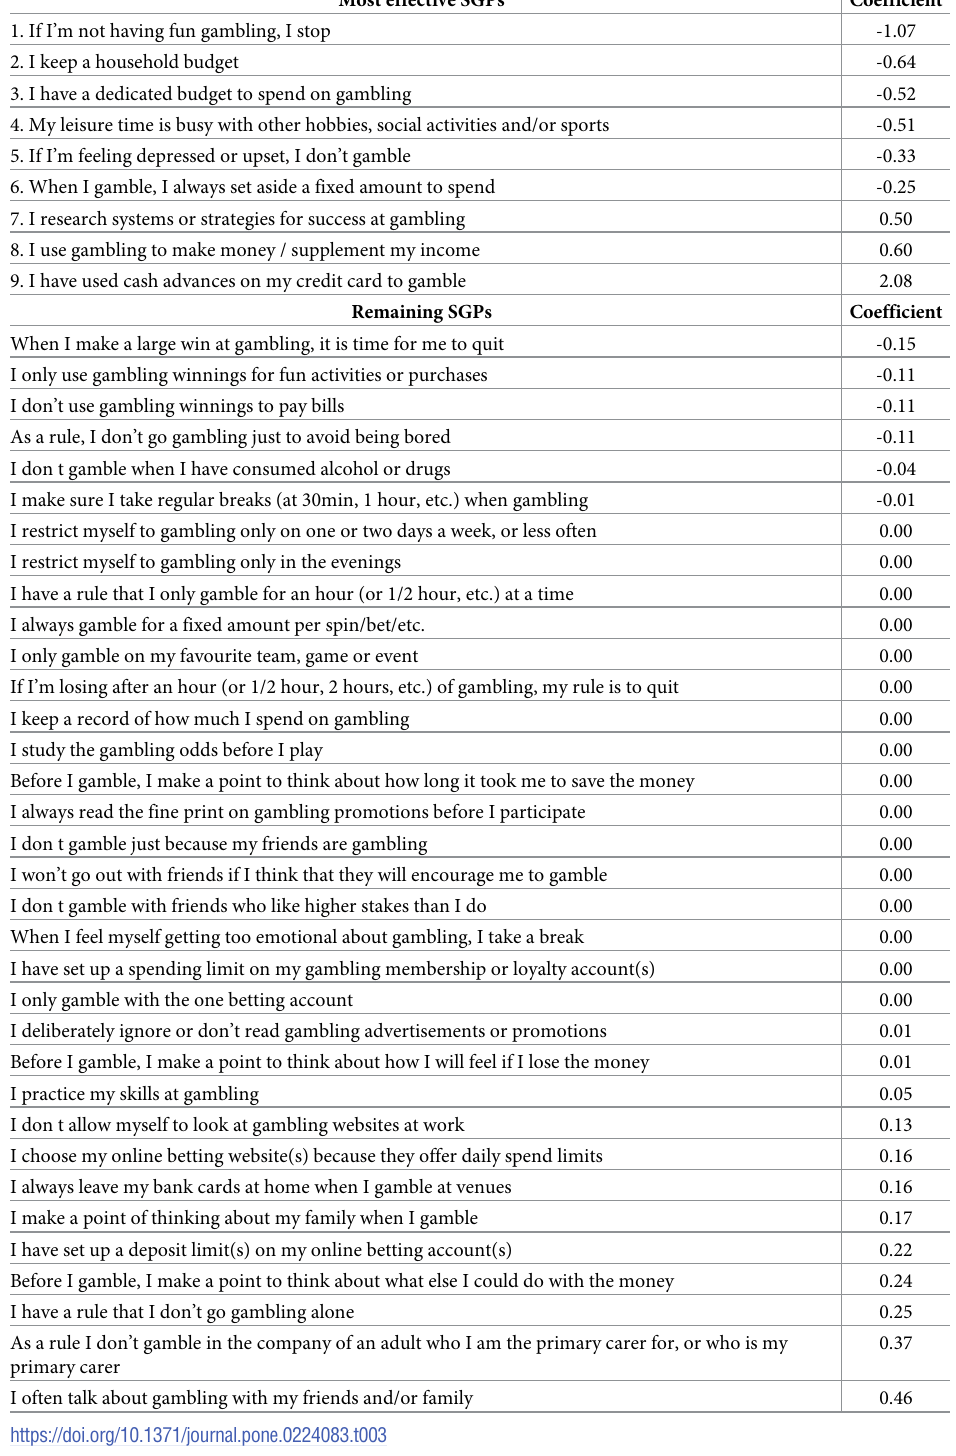
Table 3. Standardised elastic net regression coefficients predicting harm from use of SGPs ( N =